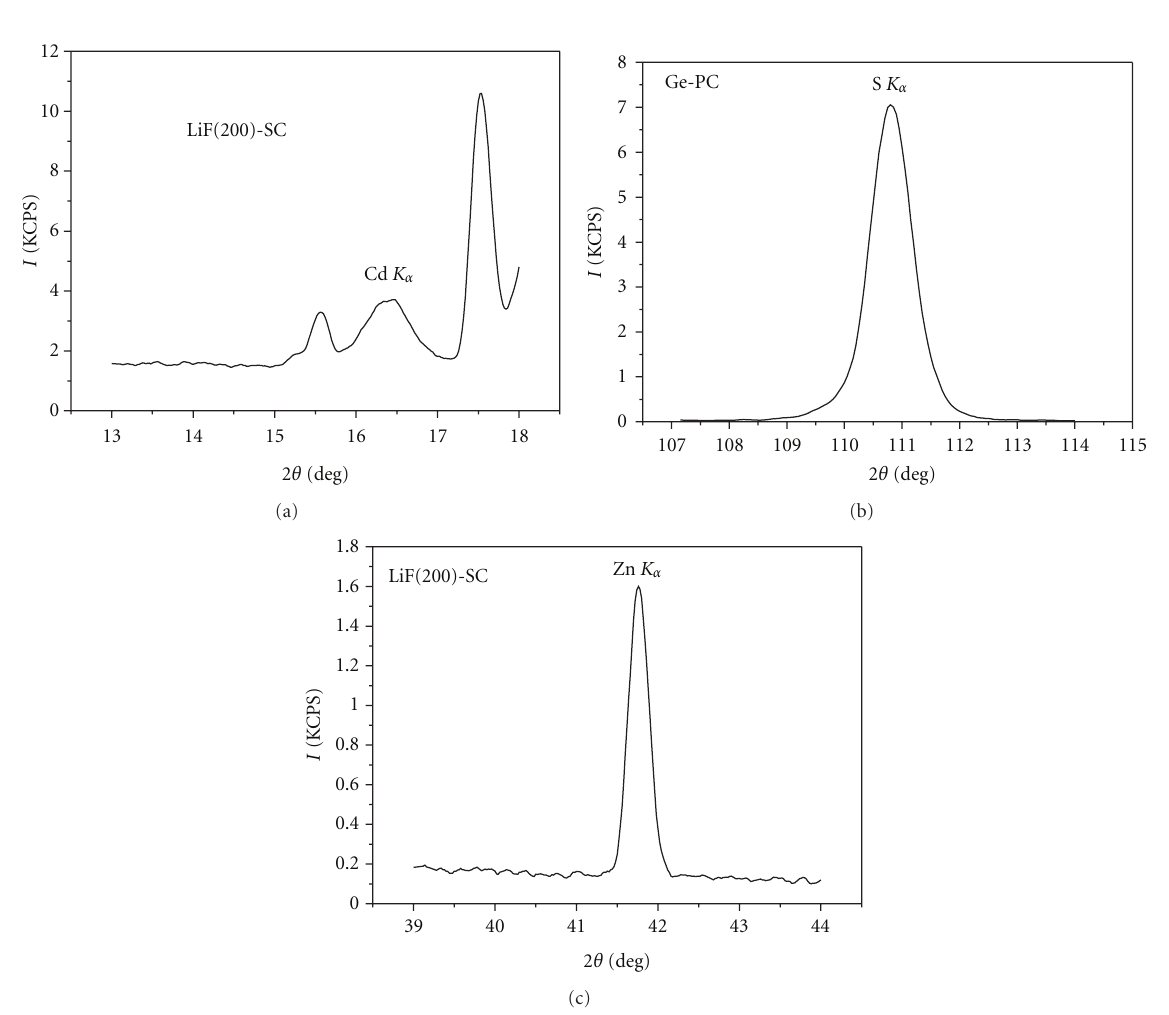
Figure 1: Typical XRF of Cd 1 − x Zn x S ( x = 0 . 61) thin films. (a) Cd- K α , (b) S- K α , and (c) Zn- K α